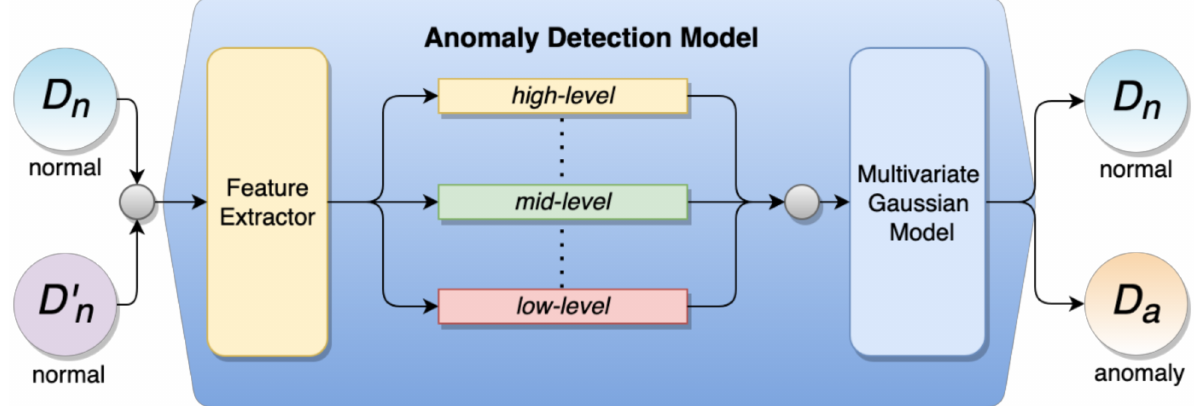
Figure 1. Hierarchical image transformation (HIT) module and multi-level features (MiLF) added to an anomaly detection model. D n represents input training data from a one-class normal image; the output of the model is normal ( D n ) or anomaly ( D a